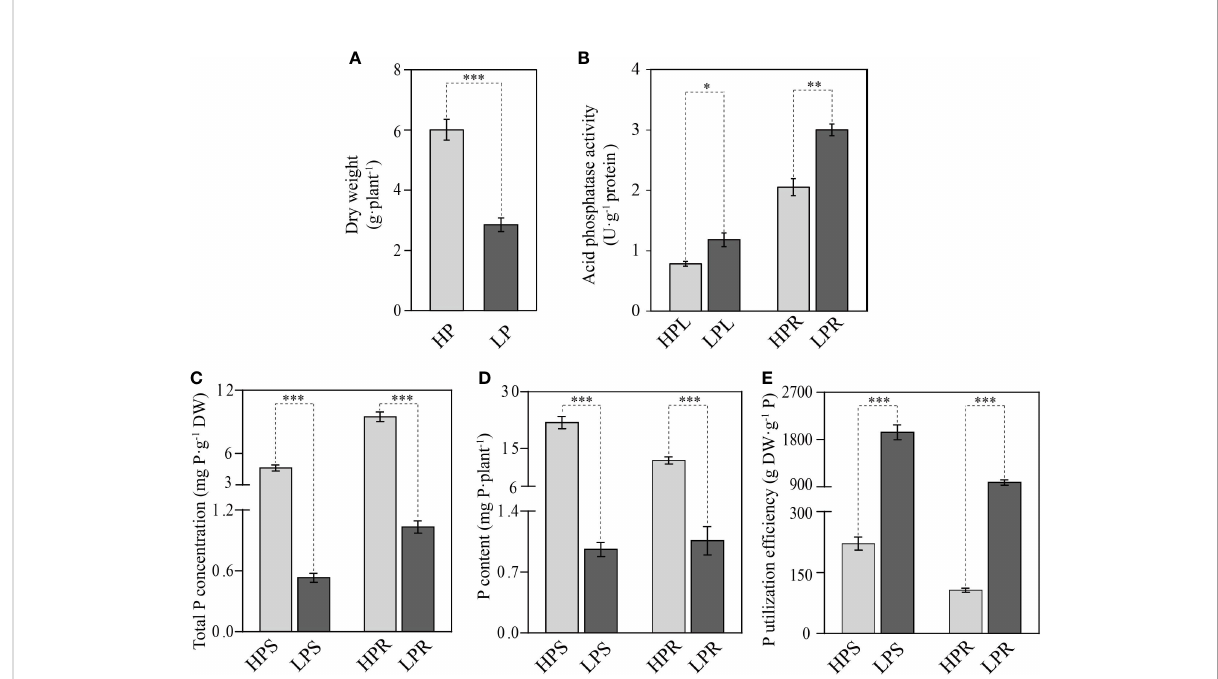
FIGURE 1 Effects of Pi starvation on elephant grass ( Pennisetum purpureum ). (A) Dry weight of total plant. (B) Acid phosphatase activity of leaves and roots. (C – E) Total P concentration (C) , P content (D) , and P utilization ef fi ciency (E) of shoots and roots. The uniform seedlings were treated with (HP) or without (LP) 600 m mol/L KH 2 PO 4 for 10 days. HPL, HPS, and HPR indicate, respectively, leaves, shoots, and roots under the HP condition LPL, LPS, and LPR indicate, respectively, leaves, shoots, and roots under the LP condition,. The data are displayed as means and standard error (SE). Signi fi cant differences between different treatments are marked by asterisks: * P < 0.05, ** P < 0.01, *** P <